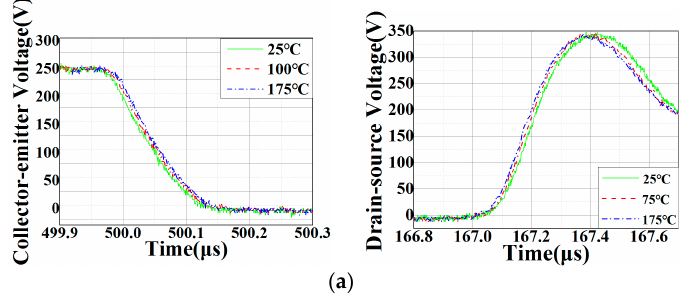
Figure 3. Turn-on and turn-off trajectories. ( a ) Si IGBT; ( b ) SiC